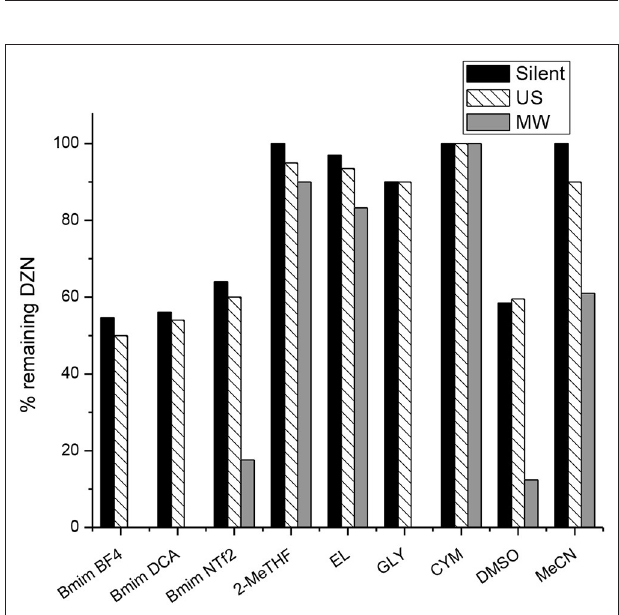
FIGURE 9 | Percentage (%) of resting Diazinon after 30min of microwave (MW) heating and 60min of ultrasound (US)waves and silent